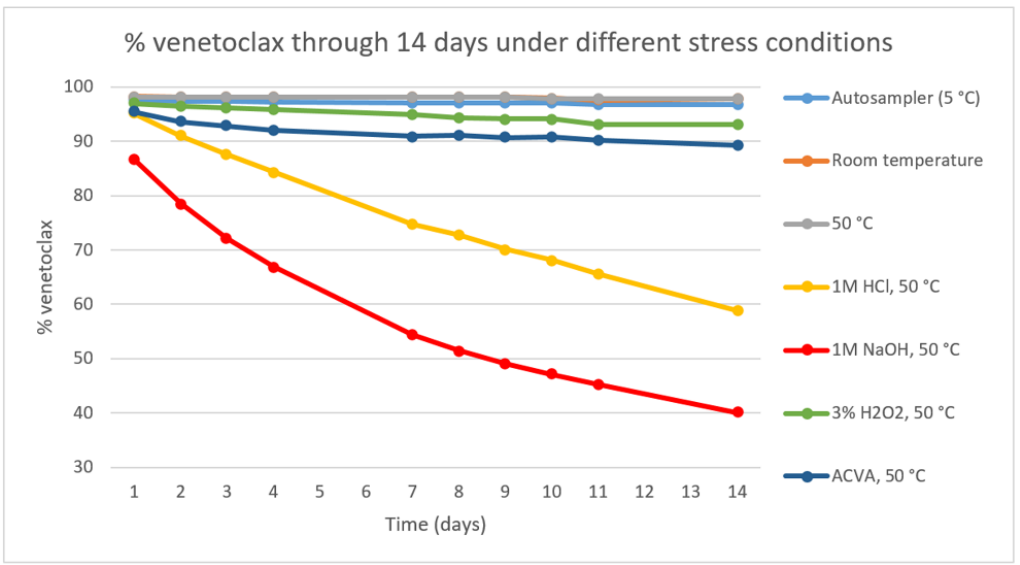
Figure 2. Line chart representing the percentage of venetoclax in the stress samples under various stress conditions over 14 days. The content was determined with an UHPLC method.